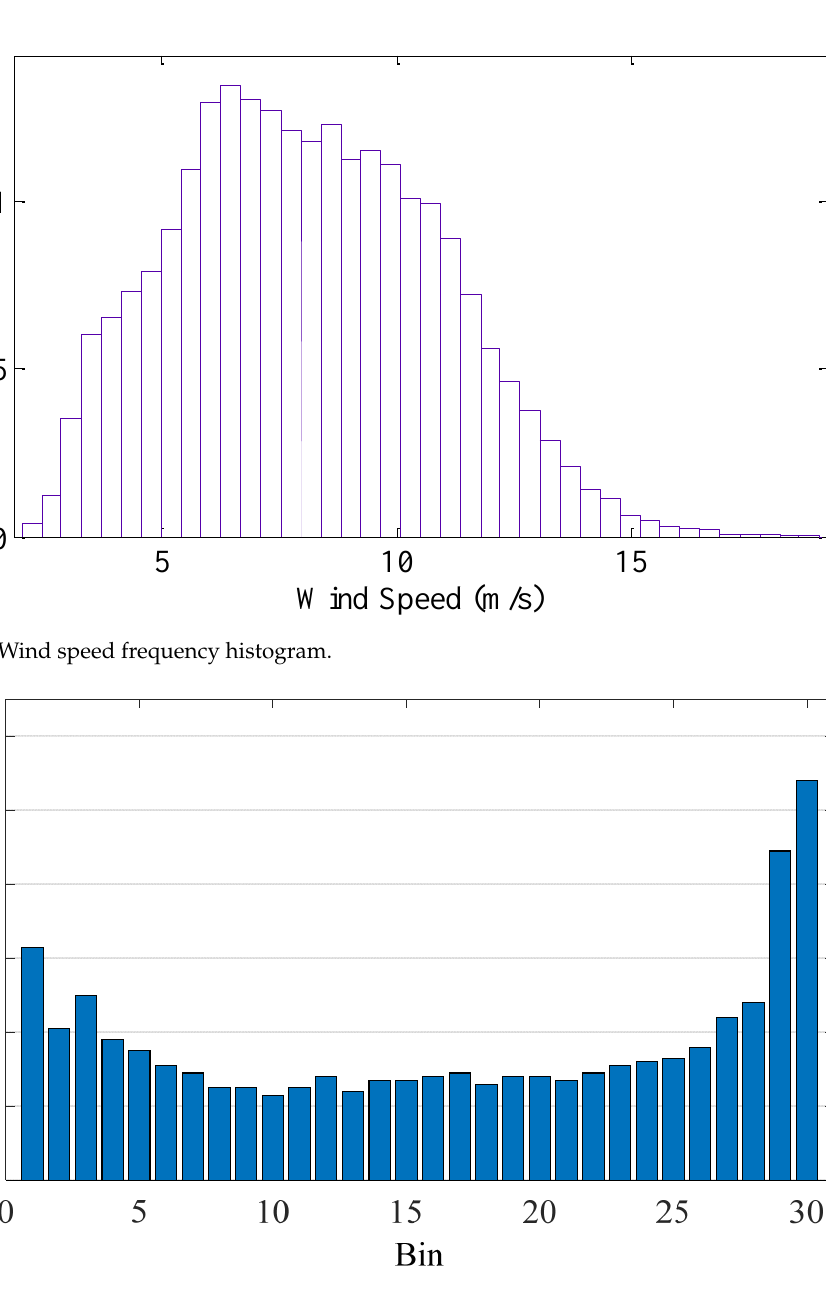
Figure 9. First-order differential histogram of wind speed based on improved Bin.